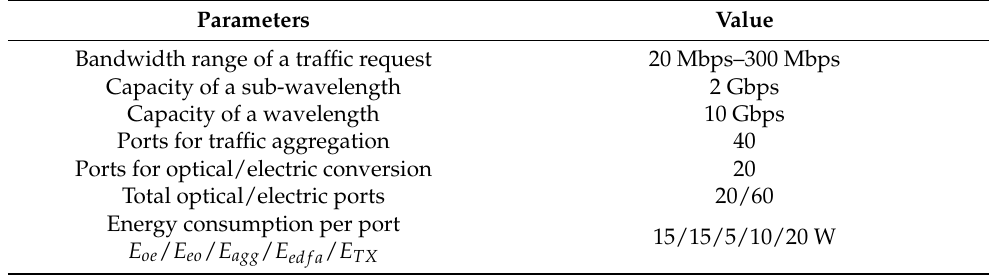
Table 1. Major simulation parameters.